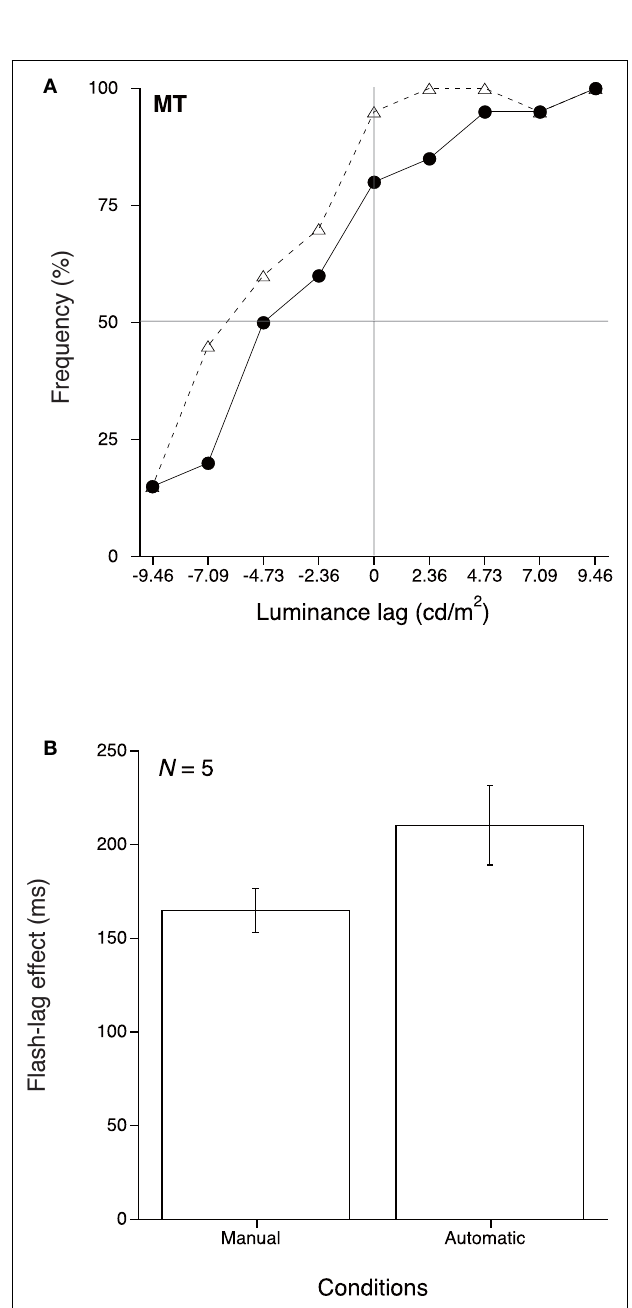
FIGURE 2 | Results of Experiment 1. (A) Example of a typical observer (MT). Solid circles and open triangles represent, respectively, results of the Manual and Automatic conditions. (B) Mean and SE of the 50% thresholds for the two